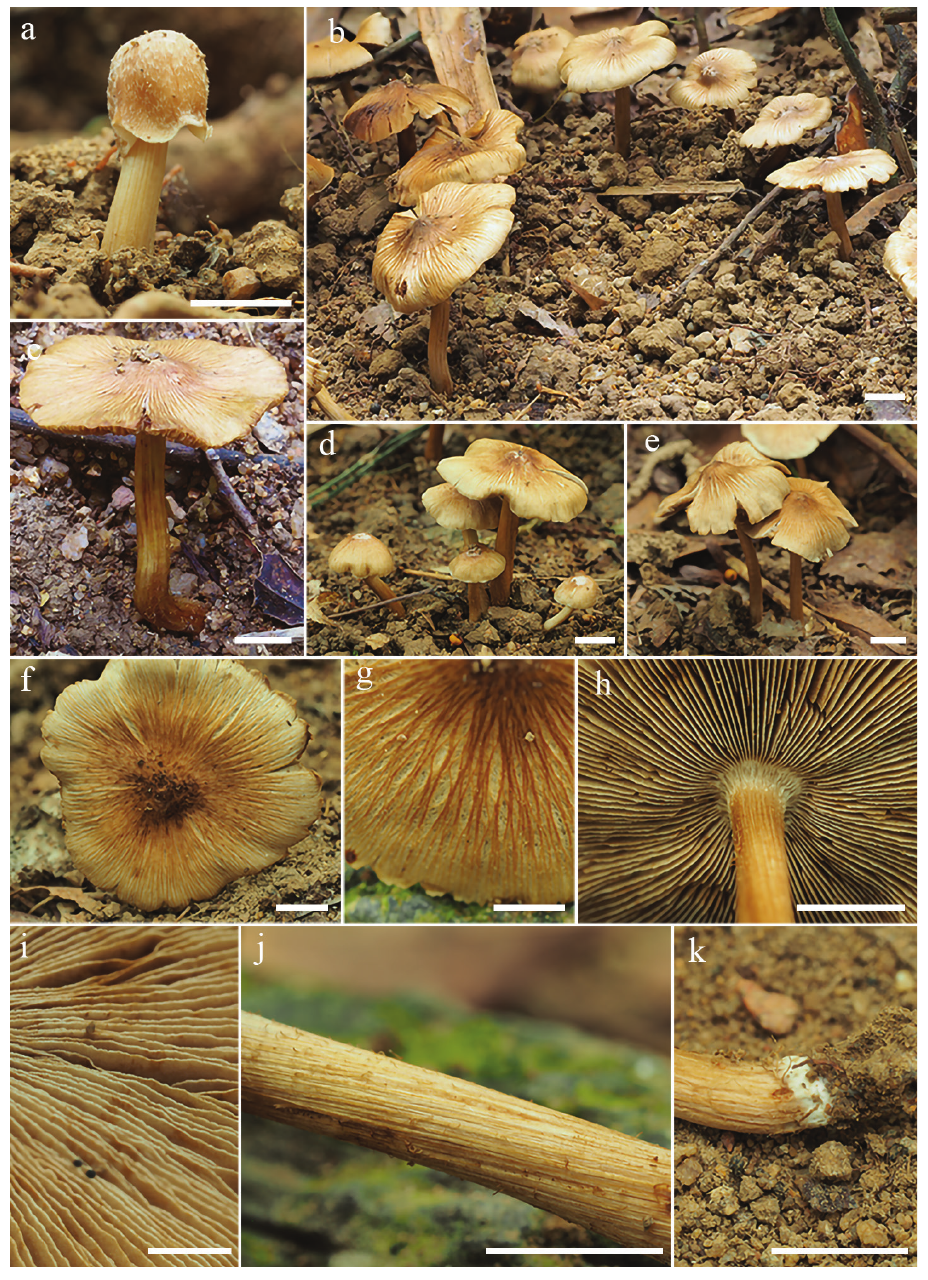
Figure 4. Basidiomata of Inosperma hainanense a–e basidiomata f–g rimose to rimulose pileus h lamellae i lamellae edge j–k stipe surface. c FHMU3166 (holotype) a–b, d–g, i–k FHMU6511 h FHMU3168. Scale bars: 10 mm ( a–k ). a–b, d–k : photos by L.-S. Deng; c : photos by N.-K.